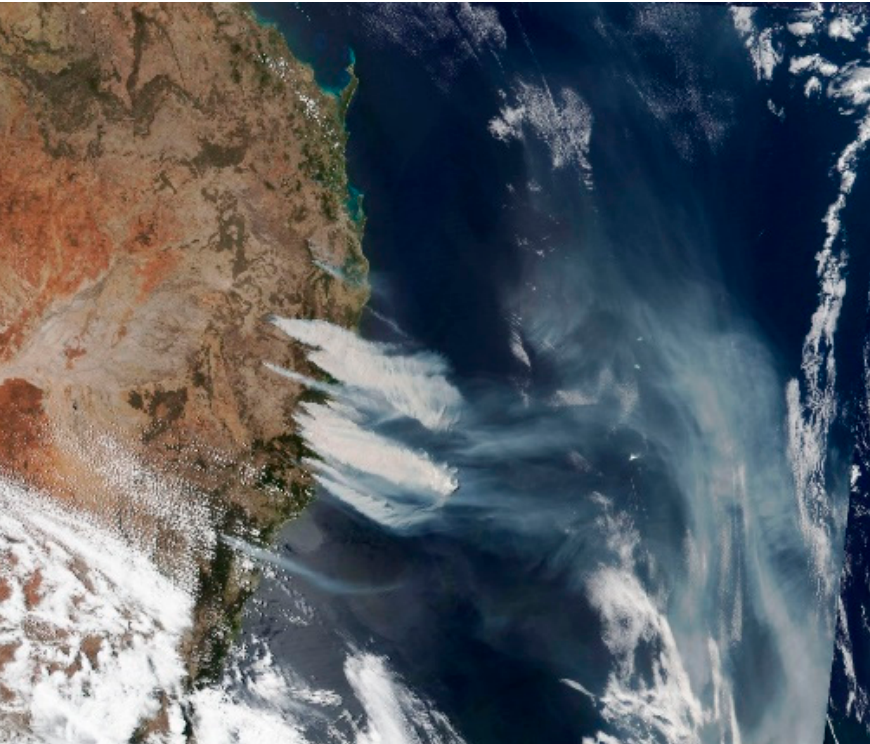
Figure 10. Australia wildfires detected by the VIIRS on the NOAA-NASA Suomi NPP satellite on 8 November 2019